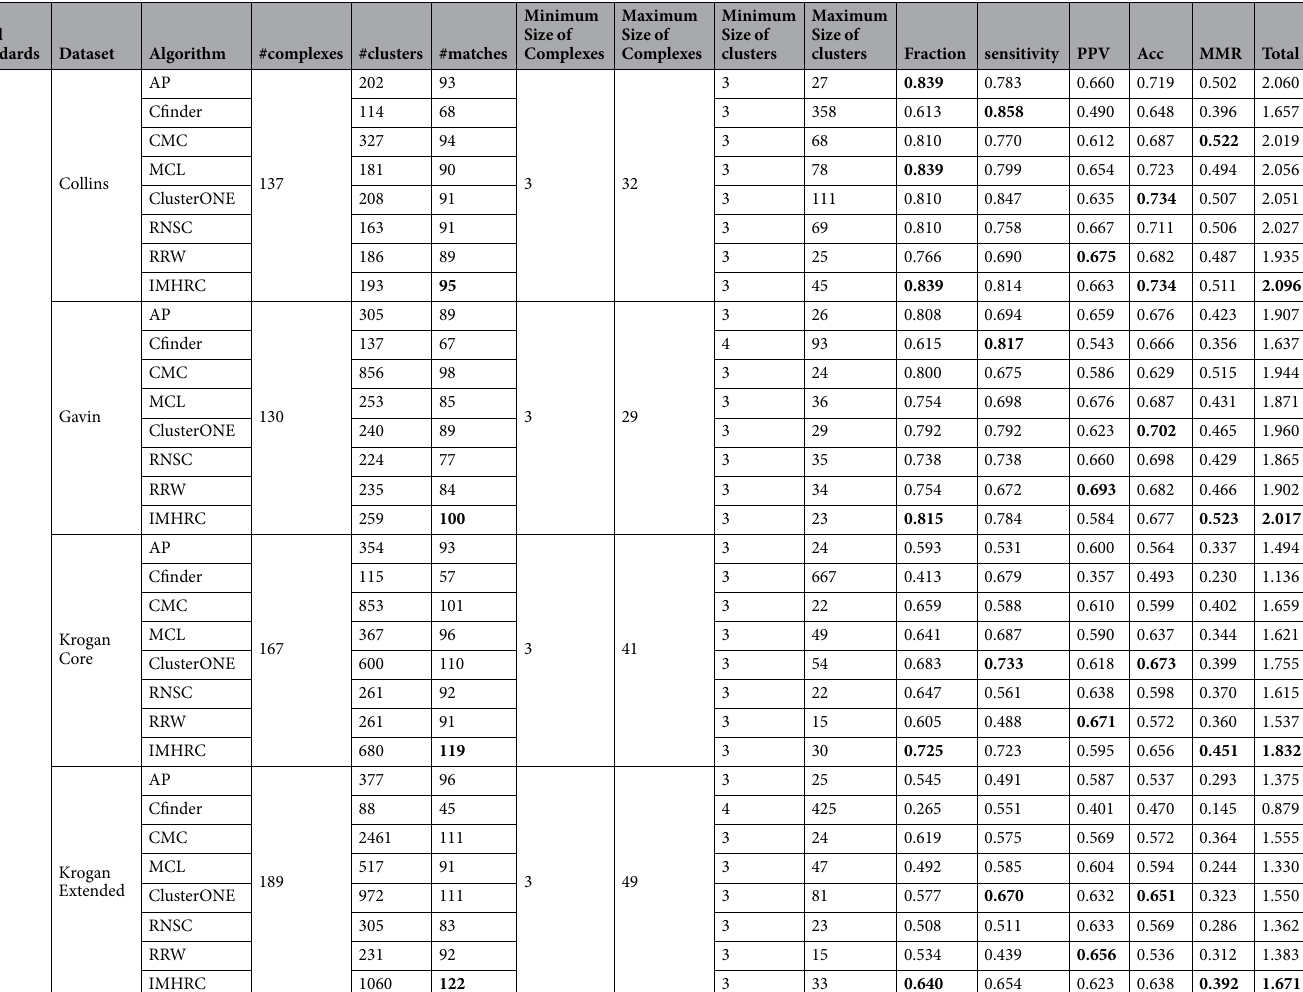
Table 4. Experimental results and performance comparison of all methods used in this paper on the SGD gold standard. The bold values show the best results in comparison with other